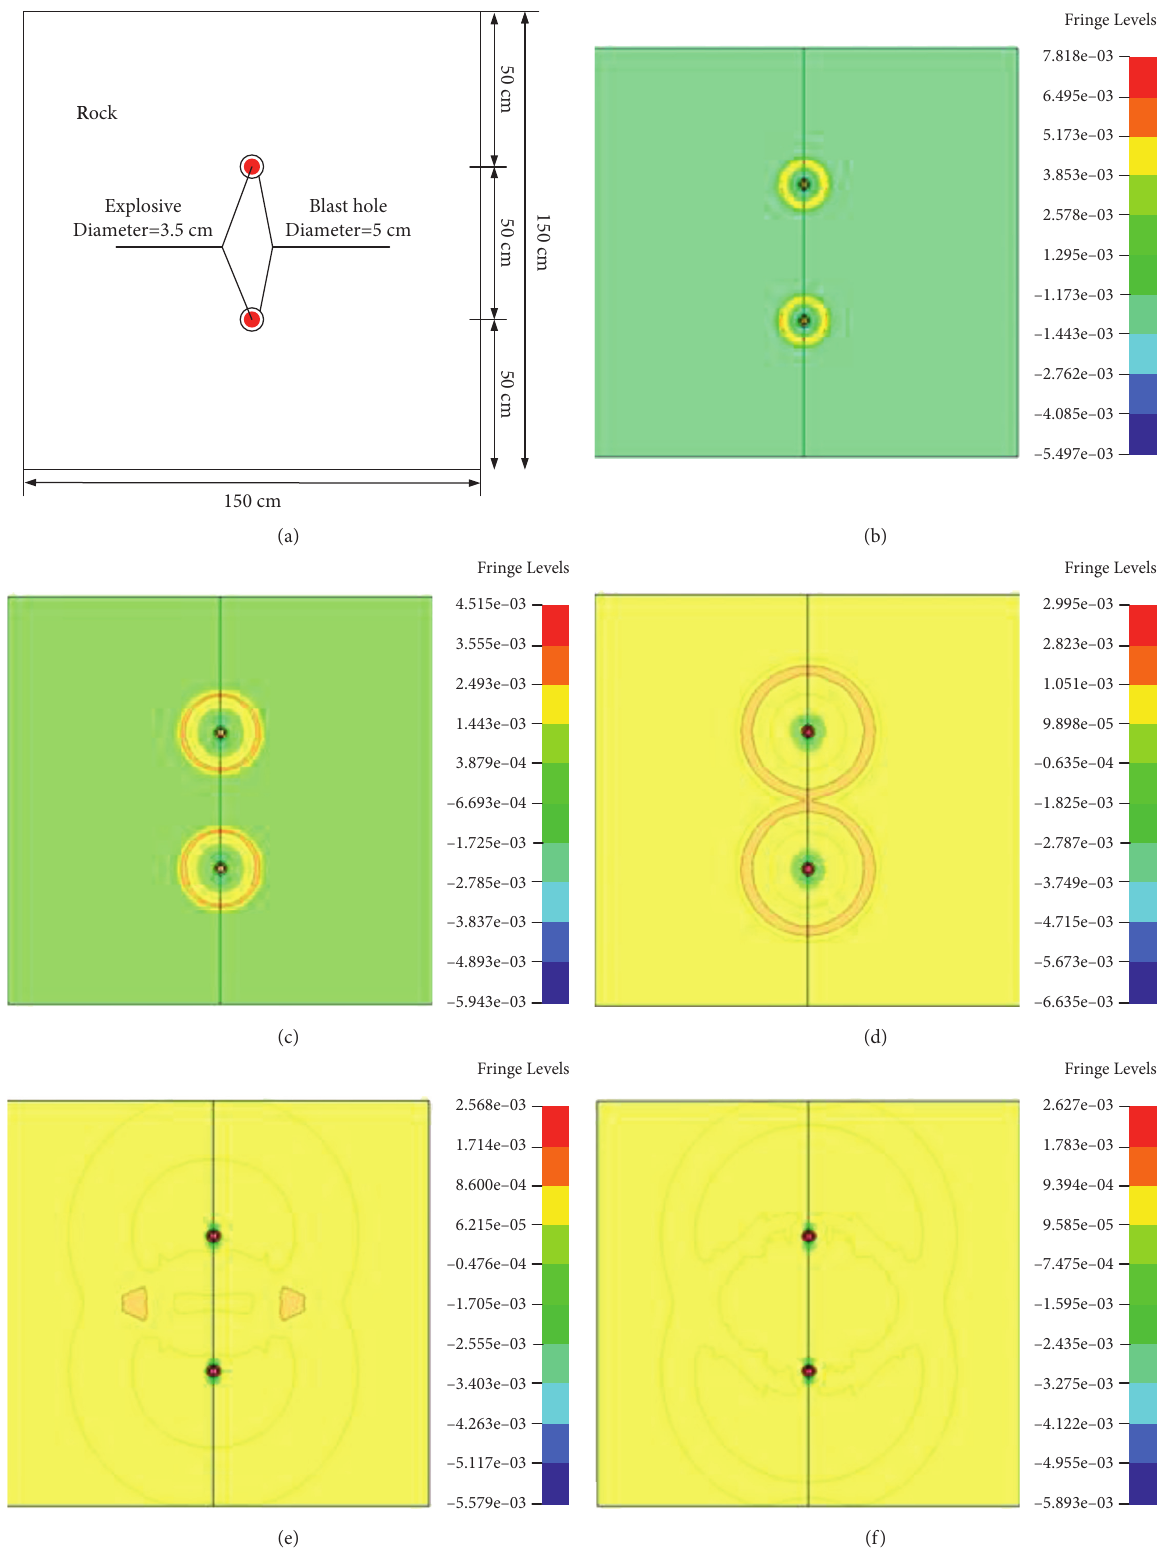
Figure 5: Construction of presplitting blasting model and evolution process of stress wave state. (a) Geometric model of presplitting blasting simulation. (b) T � 25 μ s. (c) T � 40 μ s. (d) T � 60 μ s. (e) T � 113 μ s. (f) T � 133 μ